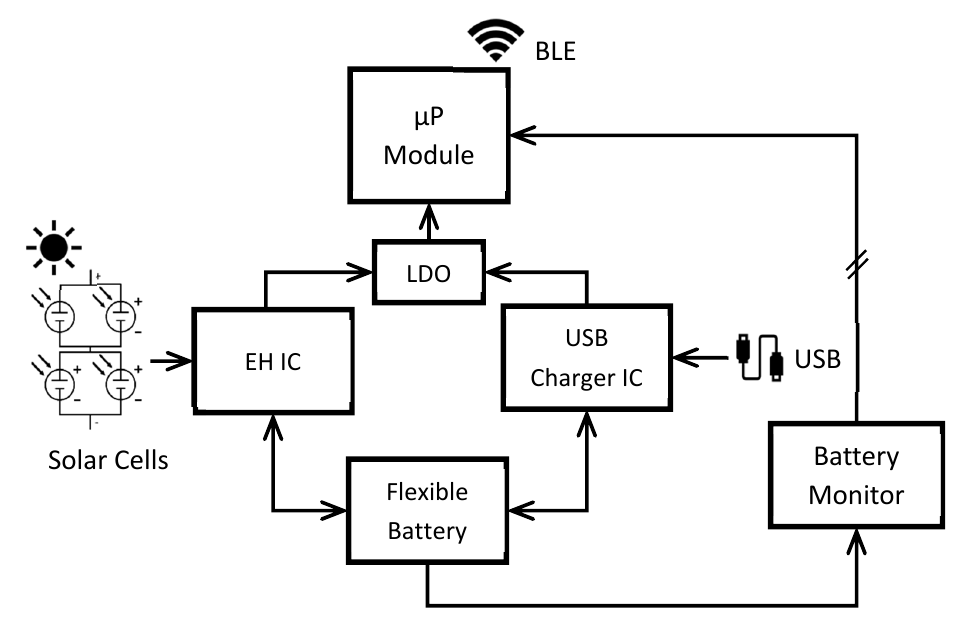
Figure 6. Schematic of the designed device.